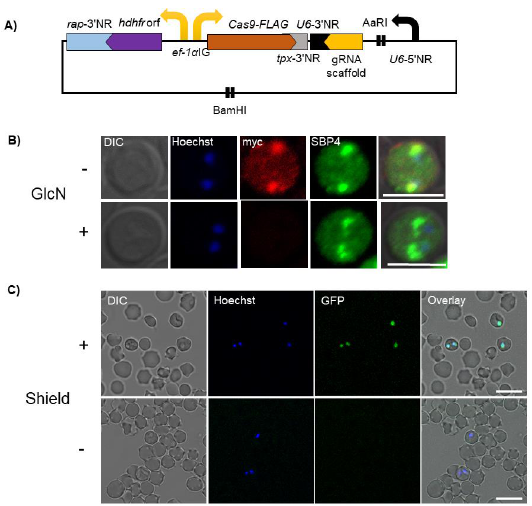
Figure 3. Schematic of CRISPR/Cas9 plasmid and conditional systems to regulate gene expression for Babesia bovis . ( A ) Cas9 and hdhfr are driven by ef1- α bidirectional promoter or intergenic region (IG) while U6 spliceosomal RNA promoter or 5 ’ noncoding region (5 ’ -NR) drives gRNA expression. The gRNA and donor DNA are inserted into AaRI and BamHI sites in the plasmid, respectively. ( B ) Indirect immunofluorescence microscopy test of BbVEAP-myc- glmS parasite in the pres- ence (+) or absence ( −) of glucosamine, GlcN (α - myc, red and α -SBP4 (control), green). The parasite nuclei were stained with Hoechst 33, 342 (Hoechst, blue). Scale bar = 5 μm. ( C ) Live fluorescence microscopy images of green fluorescent pro- tein- destabilizing domain (GFP-DD)-expressing parasites in the presence (+) or absence ( − ) of Shield. The parasite nuclei were stained with Hoechst 33, 342 (Hoechst, blue). Scale bar = 10 μm. DIC, differential interference contrast.